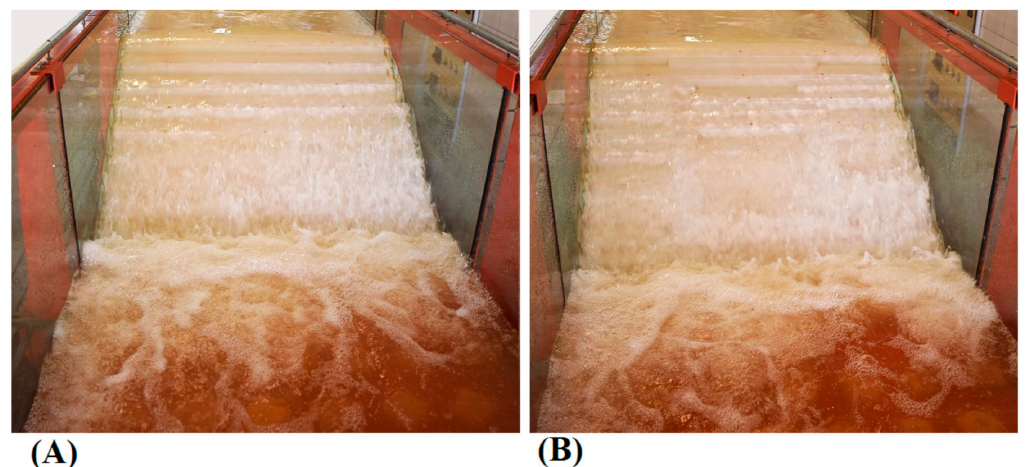
Figure 14. Flow over the stepped spillway and its interference on transverse sides of the appendance elements on step ( A) : Flat step ( B) : Hybrid appendance elements step.